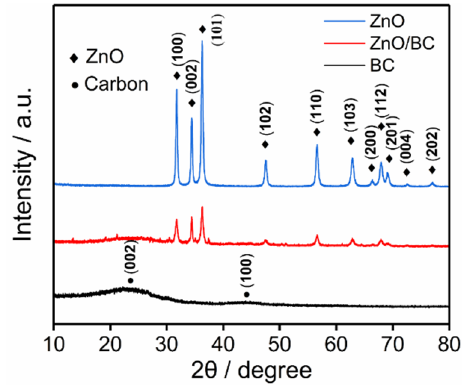
Figure 2. XRD patterns of ZnO/BC nanohybrid.